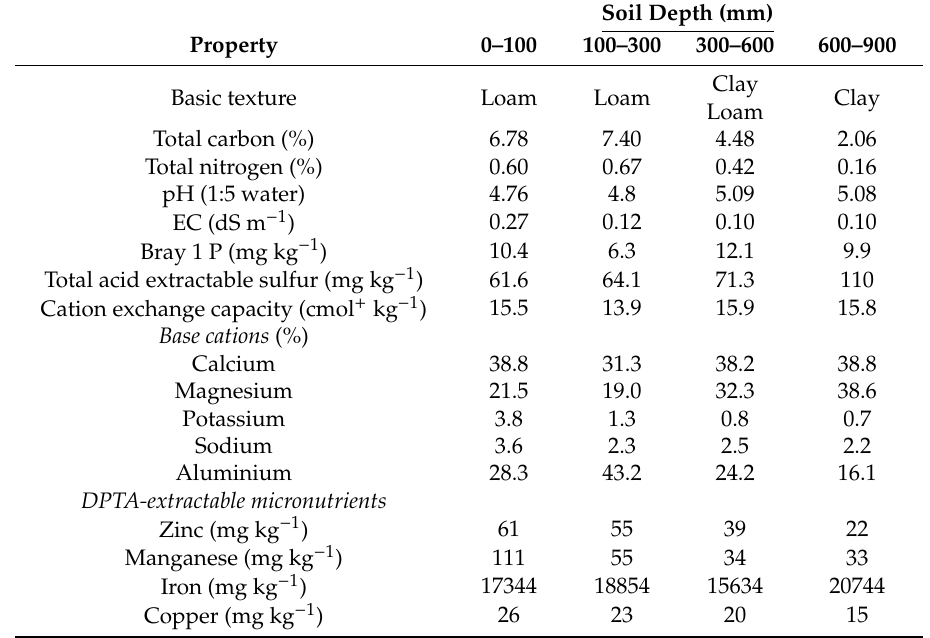
Table 1. Selected physiochemical chemical properties of the 0–100 mm, 100–300 mm, 300–600 mm and 600–900 mm horizons of the acidic Gleysol. EC: electrical conductivity.